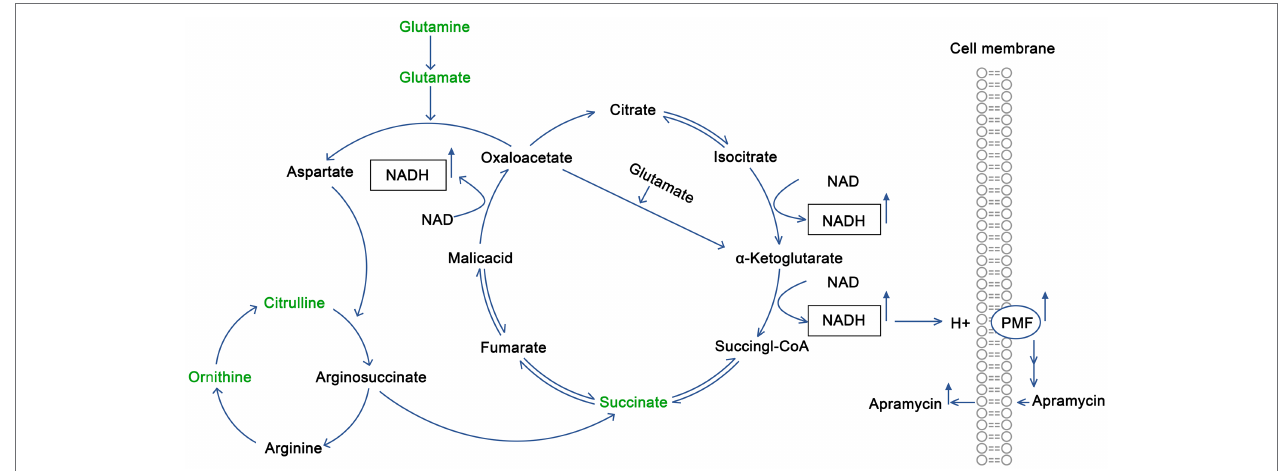
FIGURE 5 | Mechanism by which exogenous citrulline and glutamine promote the recovery of sensitivity of drug-resistant Salmonella to